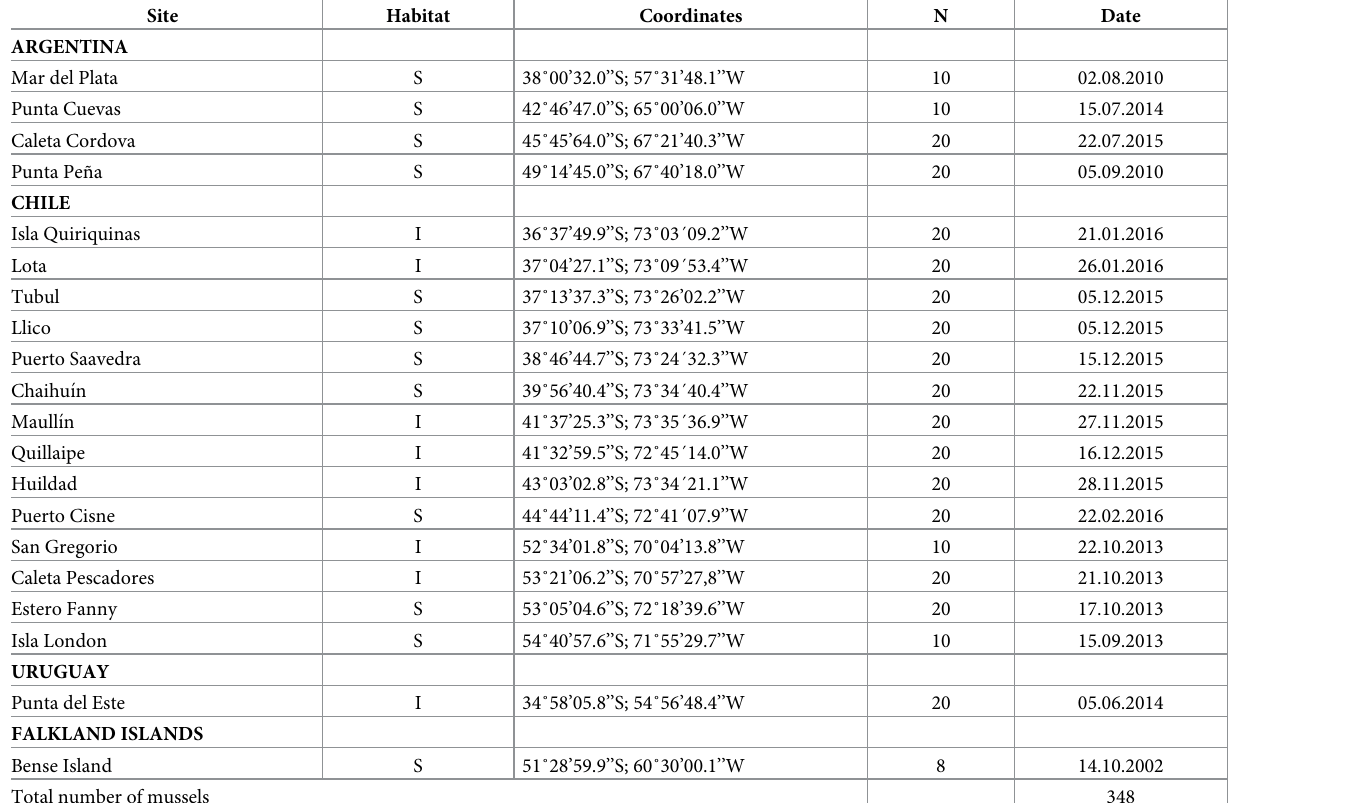
Table 1. Collection site information in Argentina, Chile, the Falkland Islands and Uruguay, including habitat (subtidal or intertidal), geographical coordinates, number of mussels ( Mytilus spp.) collected (N), and date of collection (DD.MM.YYYY).